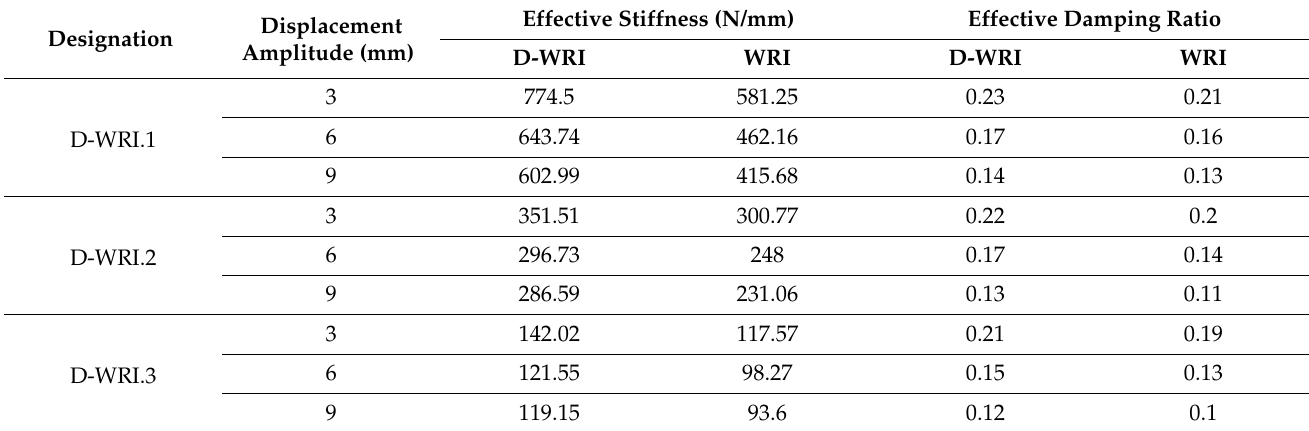
Figure 10. Hysteresis behavior of D − WRI: ( a ) compression/tension and ( b ) roll directions. Table 7. Effective stiffness and effective damping in the compression/tension direction.